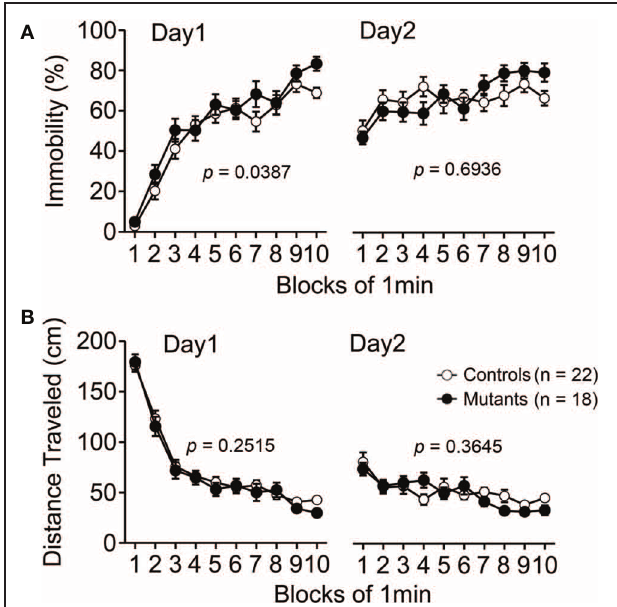
FIGURE 4 | Normal performance in behavioral despair of Apc + / − mice 9–10 weeks of age in the Porsolt forced swim test. (A) Apc + / − mice showed a significant decrease in immobility time compared to wild-type mice at day 1, whereas there was no significant difference between genotypes at day 2. (B) No significant differences between genotypes in distance traveled were observed. Apc + / − mice, n = 18; wild-type mice, n = 22.